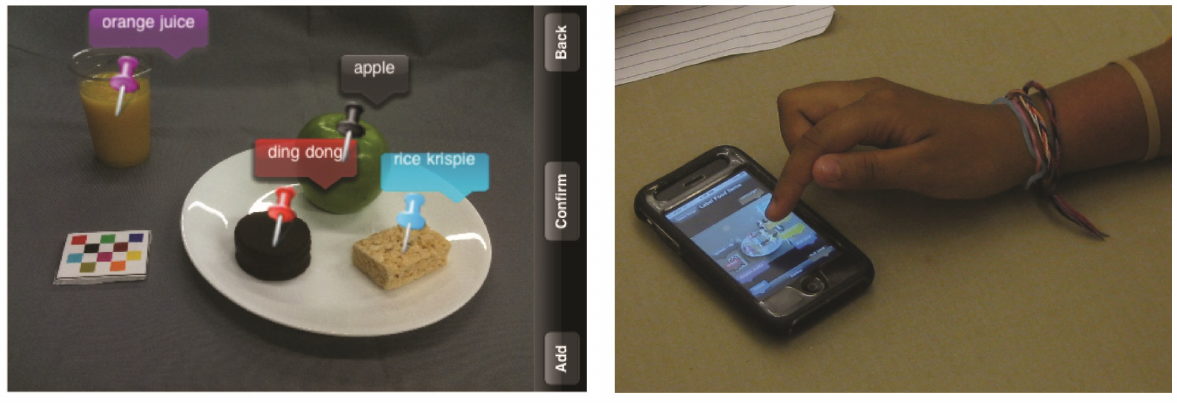
Figure 3. Beta testing the review component. The user selects an eating occasion to review. The before-eating image is in landscape view as displayed on the left. Foods are denoted with pins and the food label appears on a color coordinated bubble. To correct a misidentified food, the user taps the bubble associated with the food as shown on the right and selects the correct food from a list of foods (not